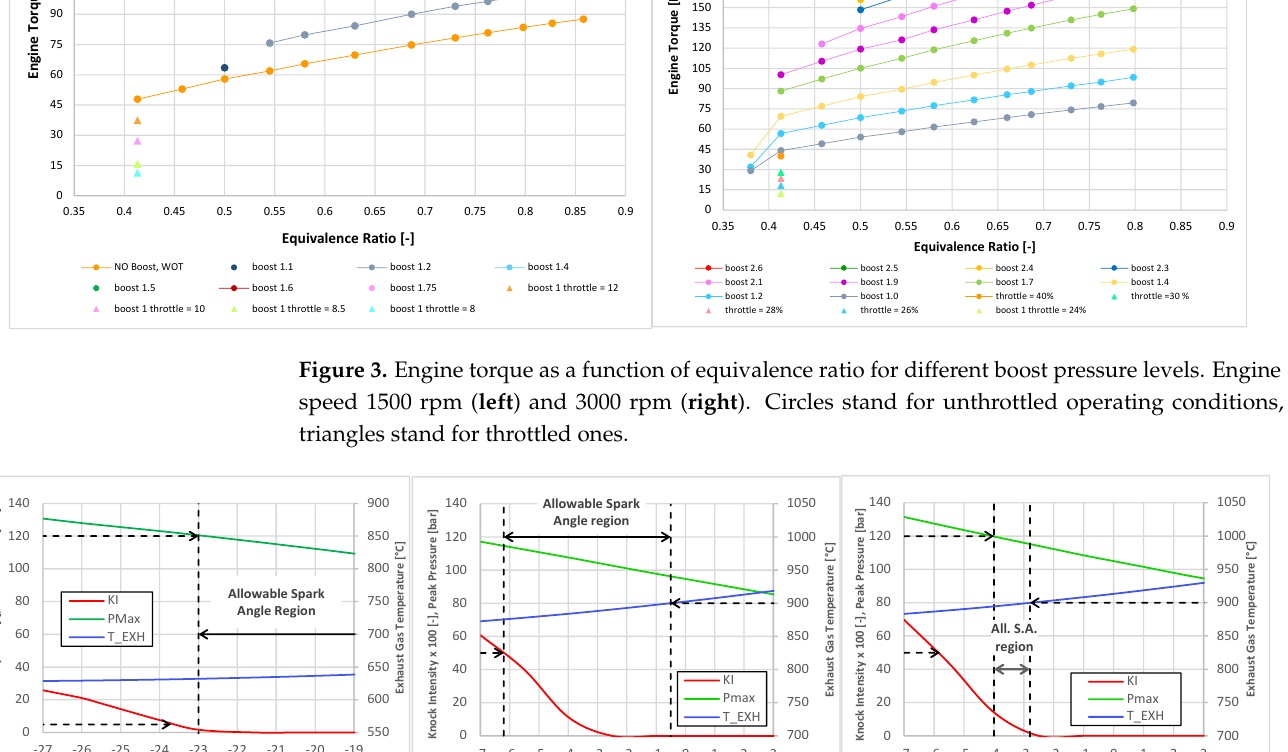
Figure 5. Engine efficiency as a function of the engine torque for different boost pressures [bar] and equivalence ratios. In some operating points, the equivalence ratio value is reported. For some boost levels, the equivalence ratio value maximizing the efficiency is also highlighted.